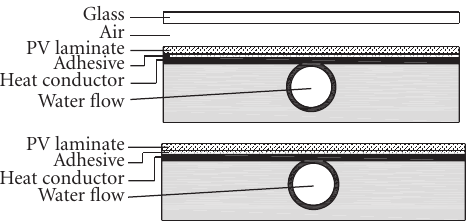
Figure 1: Sectional view of a glazed (above) and unglazed (below) PVT collector.